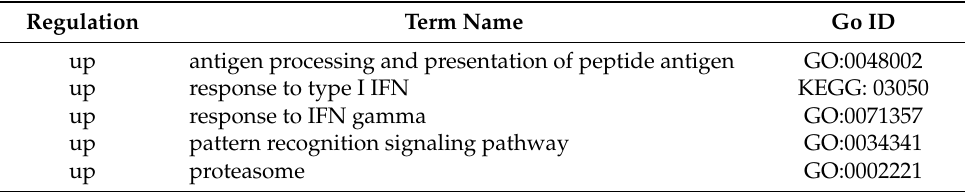
Table 1. Overview of selected GO/KEGG terms for a more detailed analysis, based on GO-term enrichment analysis of di ff erentially regulated genes with the gPro fi ler software (Table S5).